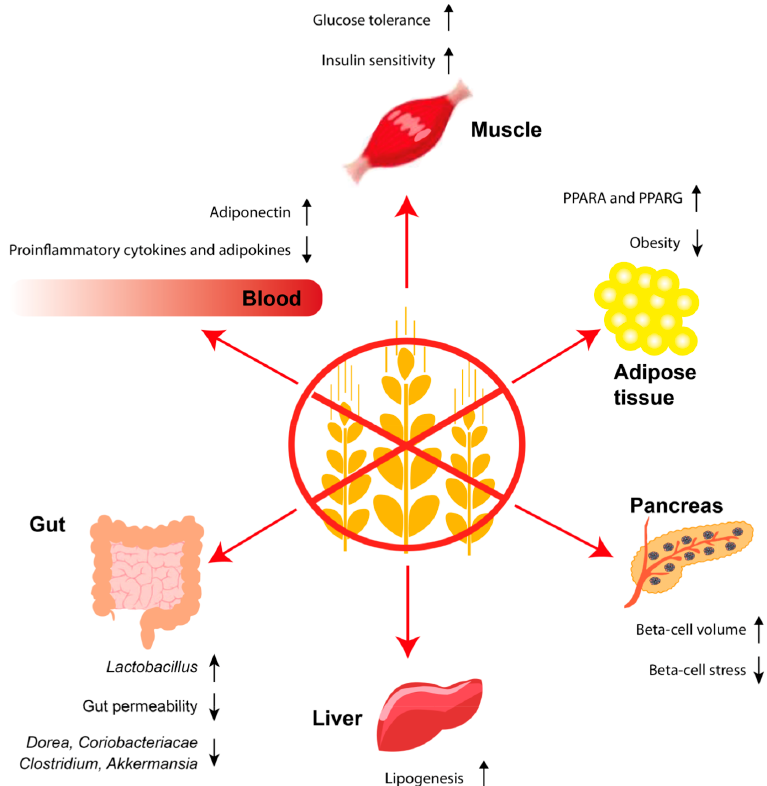
Figure 2. Gluten-free (GF) diet and the development of type 2 diabetes (T2D)—a hypothesis. A GF